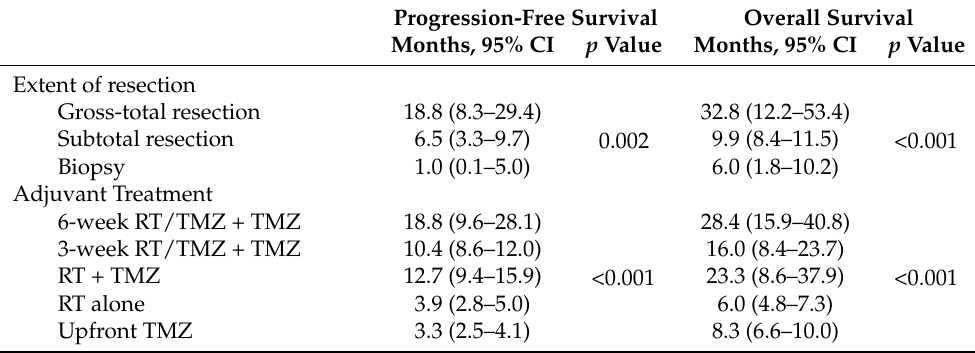
Table 7. Progression-free Survival and Overall Survival according to the Extent of Resection and Adjuvant Treatment